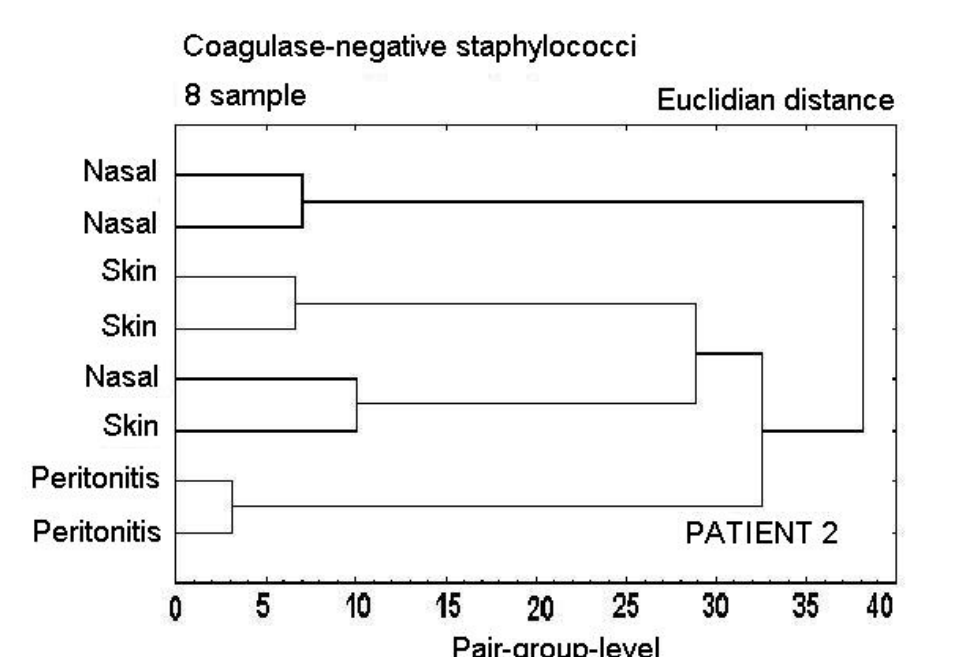
Figure 6: Similarity dendrogram drawn based on inhibition halos obtained by using the agar disk diffusion technique for coagulase-negative staphylococci isolated from the nasal cavity, pericatheter skin and peritoneal effluent of one patient undergoing peritoneal